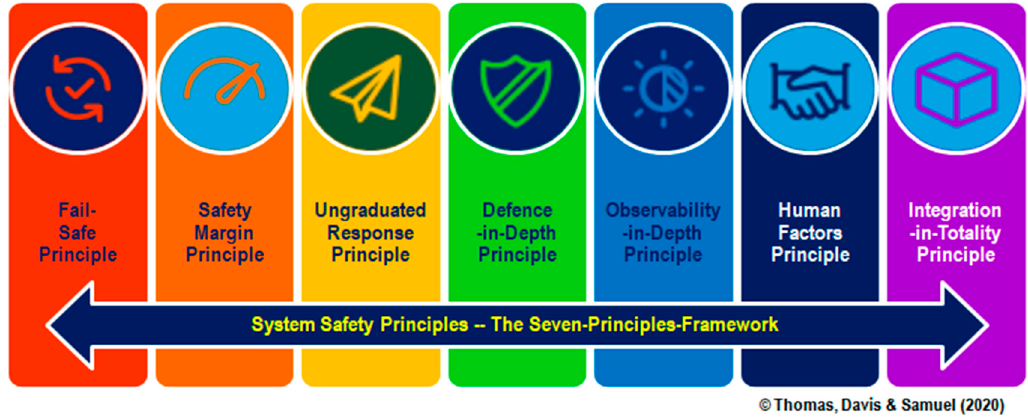
Figure 1. The Seven-Principles-Framework of System Safety Principles.